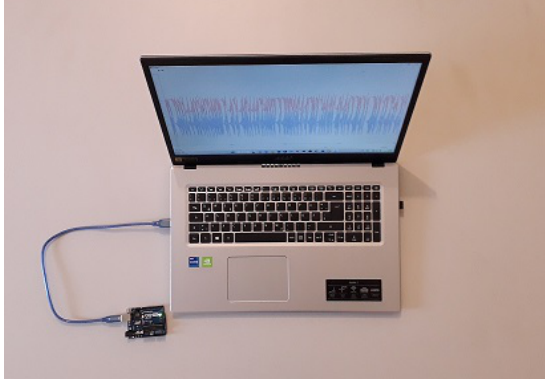
Figure 8. The setup of the